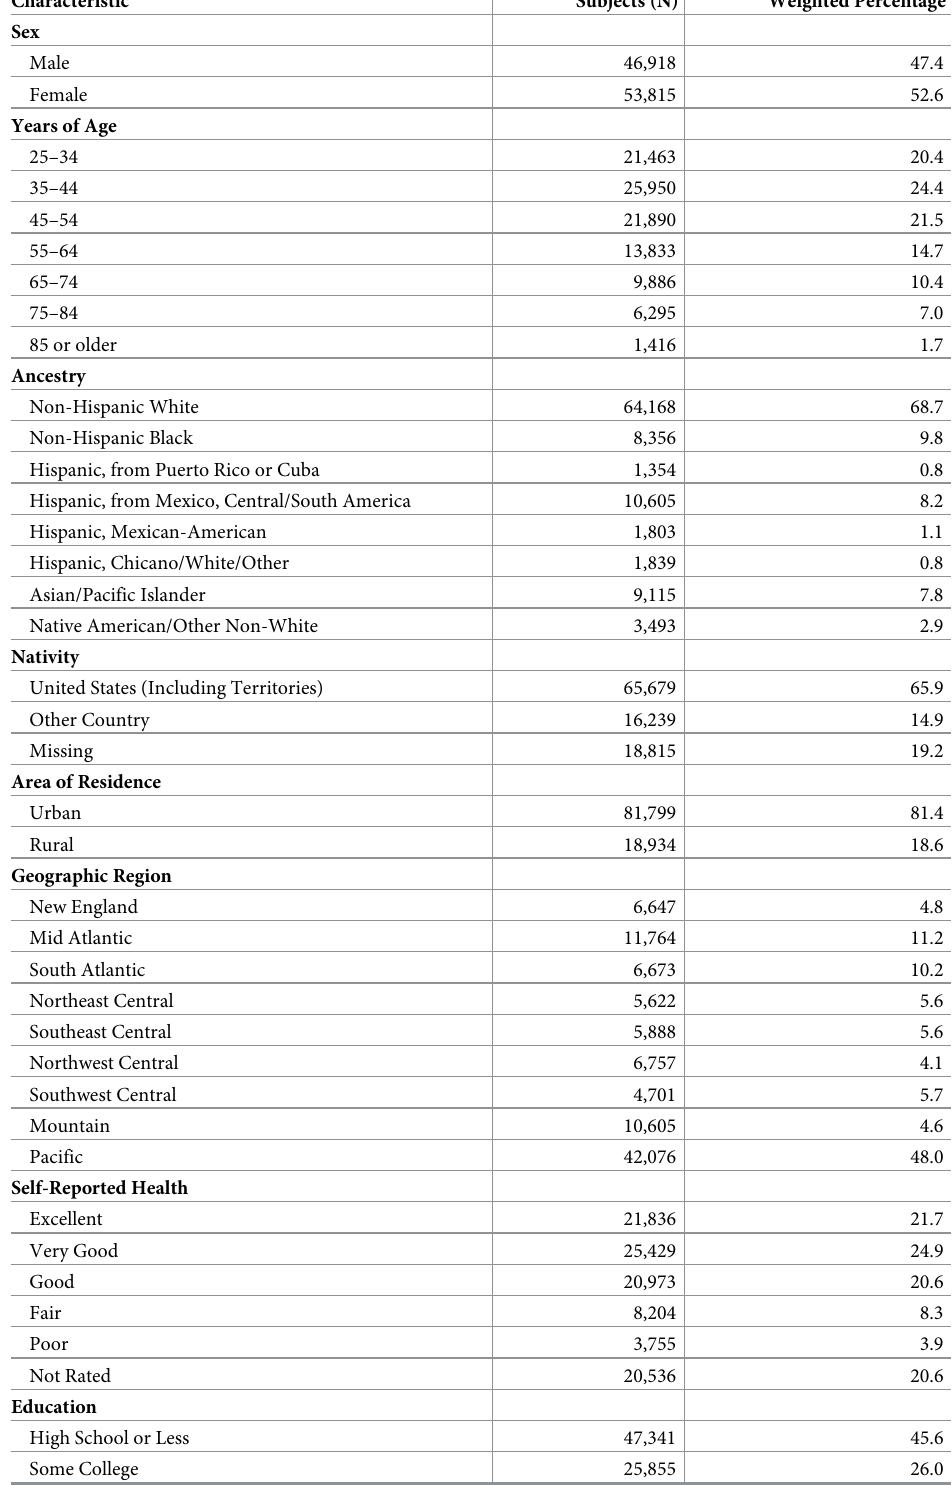
Table 1. Characteristics of subjects at enrollment (N =